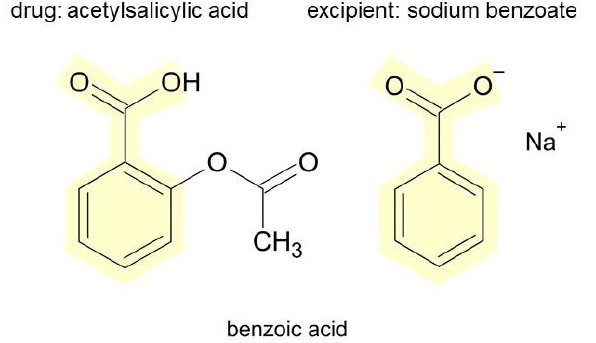
Figure 2. Comparison of the chemical formulas of ASA and its excipient sodium benzoate, which share the same benzoic acid structure (in yellow). Sketches were created with ChemSketch software, 2018.2.1. (Advanced Chemistry Development Inc., Ontario, Canada)